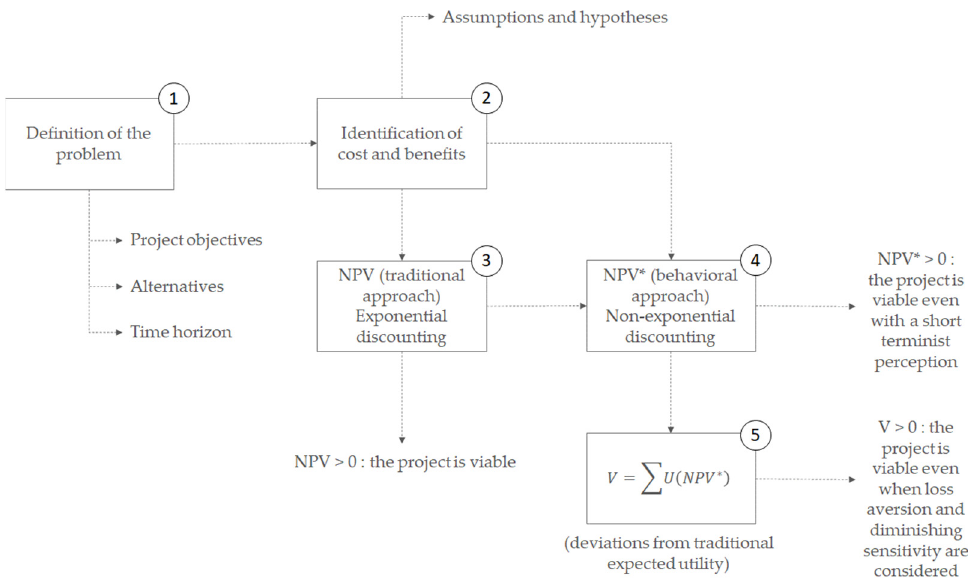
Figure 21. Methodological diagram for the new proposed CBA behavioral framework.